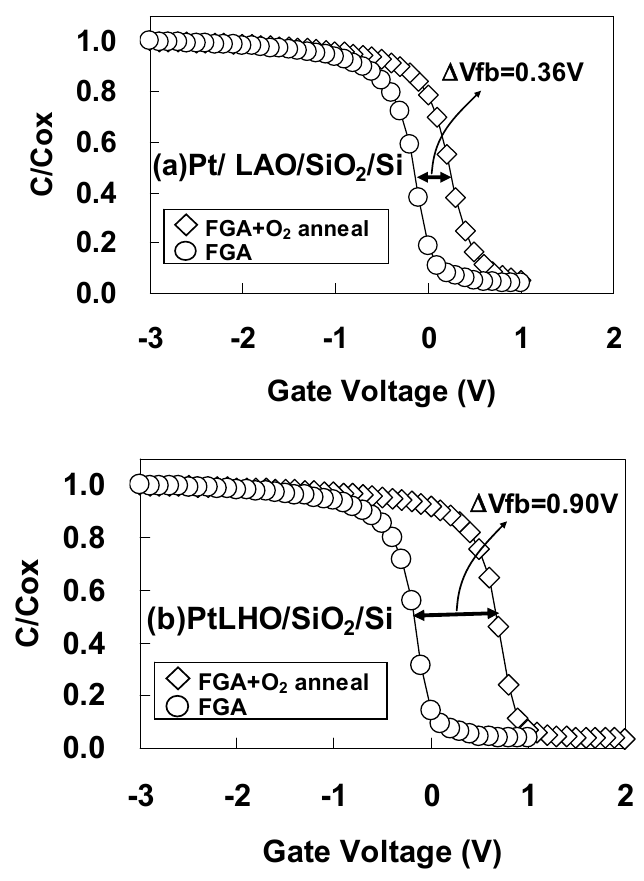
Figure 21. C-V curves for the highest capacitances for ( a ) Pt/LAO/SiO /Si MOS capacitors after forming gas annealing (FGA) only and after ( b ) Pt/LHO/SiO 2 additional O 2